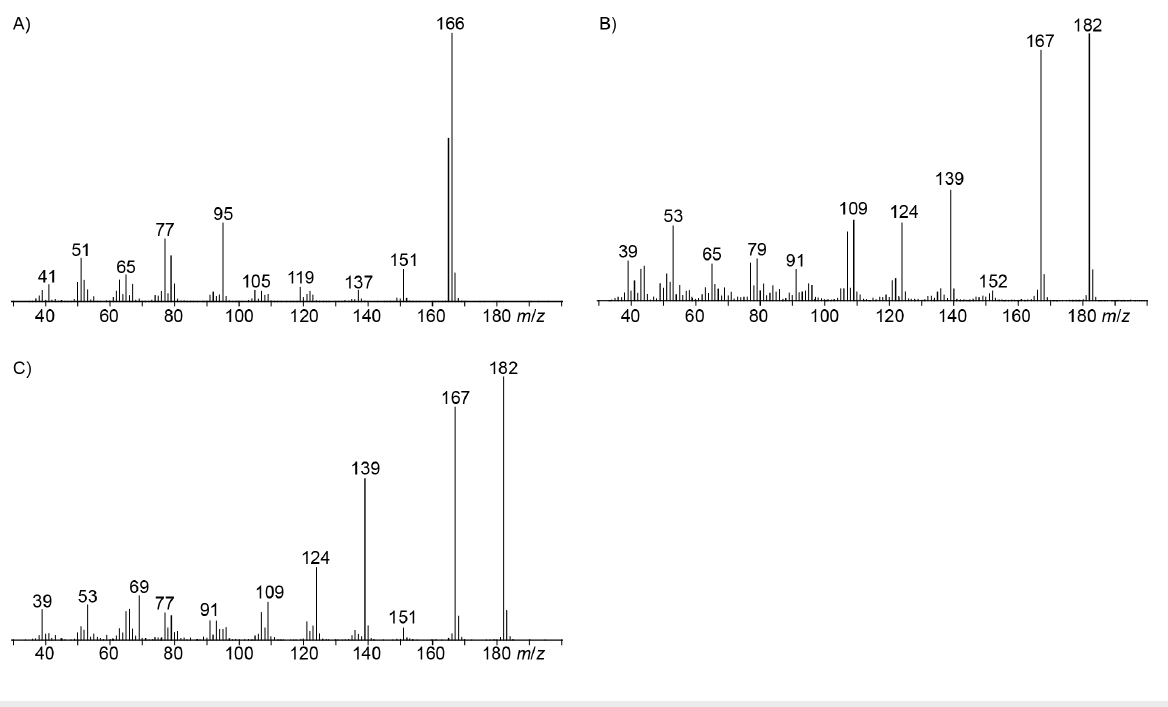
Figure 8: EI mass spectra of A) 3,4-dimethoxybenzaldehyde ( 42 ), B) 3,4,5-trimethoxytoluene ( 44 ), and C) 2,4,5-trimethoxytoluene ( 45 ).